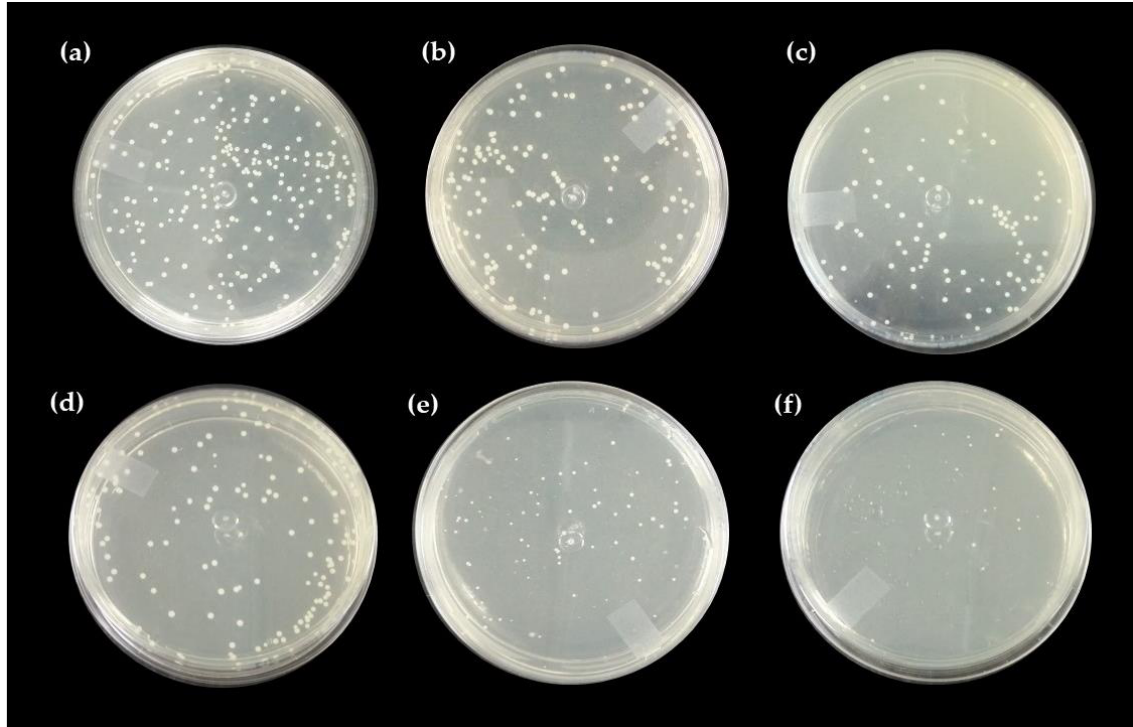
Figure 5. Direct contact test for ( a ) control, ( b ) N1, ( c ) N2, ( d ) GChi, ( e ) GChiN1, and ( f ) GChiN2 against Staphylococcus aureus (ATCC 25,923).